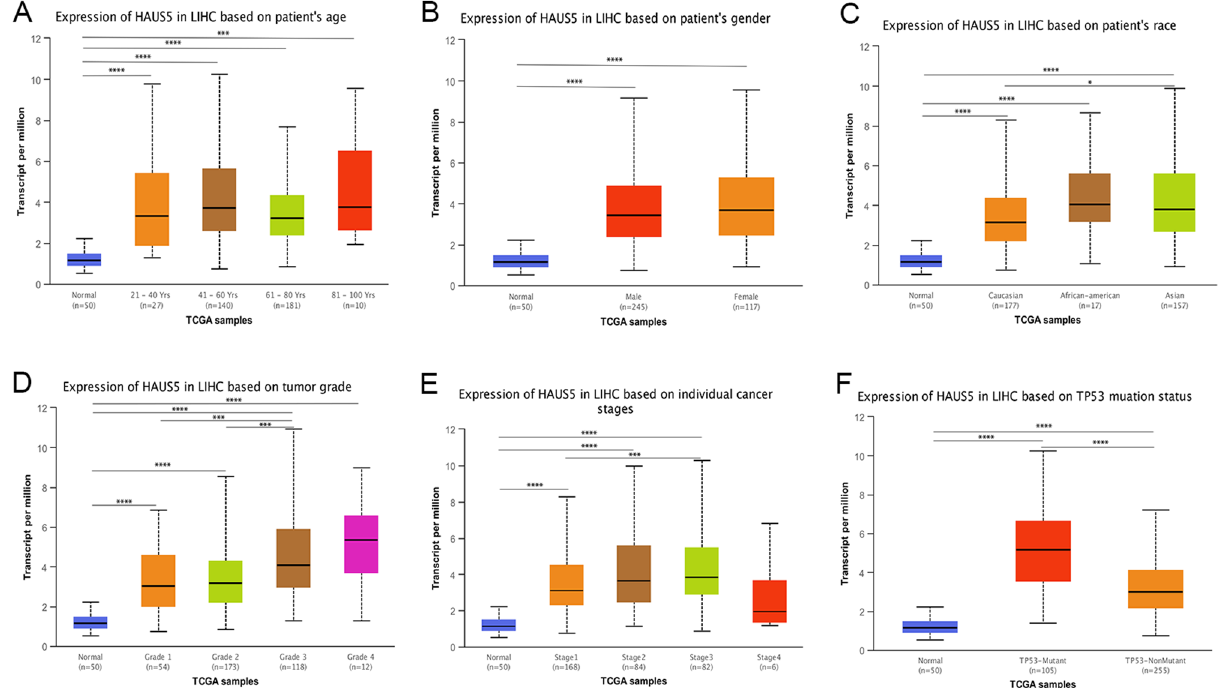
Figure 4. Association between the expression level of HAUS5 and clinical features in LIHC analyzed via the UALCAN database. HAUS5 differential expression in liver cancer patients according to the characteristics of age ( A ), sex ( B ), race ( C ), tumor grade ( D ), cancer stage ( E ) and TP53 mutation status ( F ). *P < 0.05, **P < 0.01, ***P < 0.001, ****P < 0.0001.